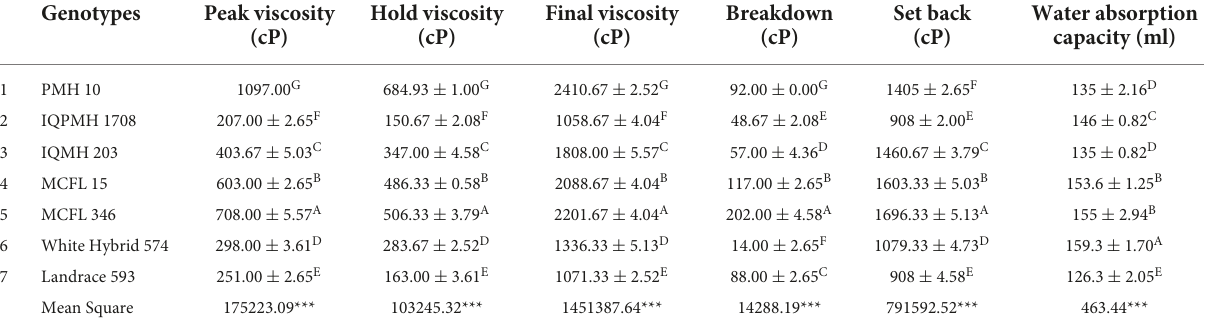
TABLE 2 Pasting properties and water absorption capacity of maize flours from different genotypes.